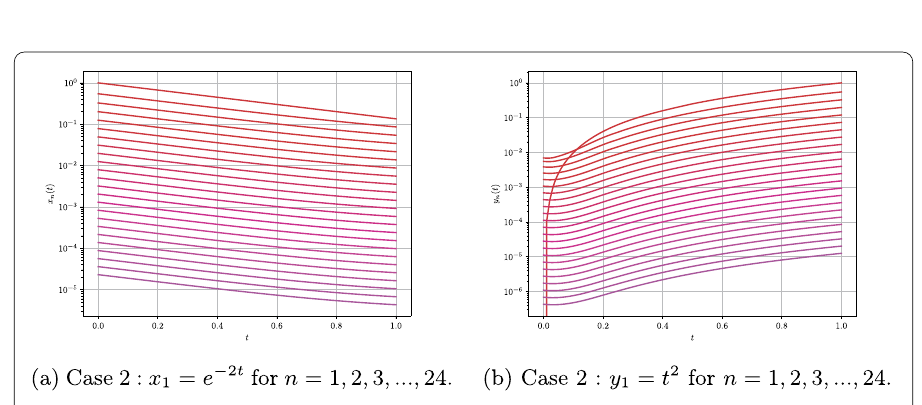
Figure 4 The convergence behavior of { x n ( t ) } and { y n ( t ) } with x 1 = e –2 t and y 1 = t 2 (Case 2) in Example 5.2, the y -axis is illustrated on a logscale